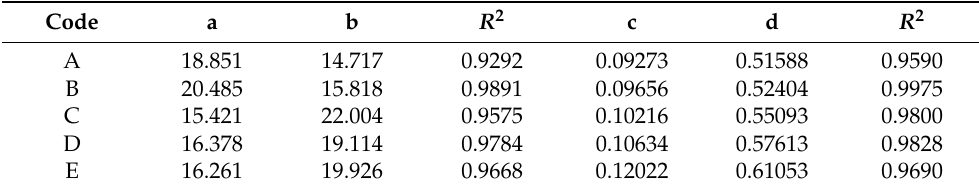
Table 6. Relation coefficients of fitted